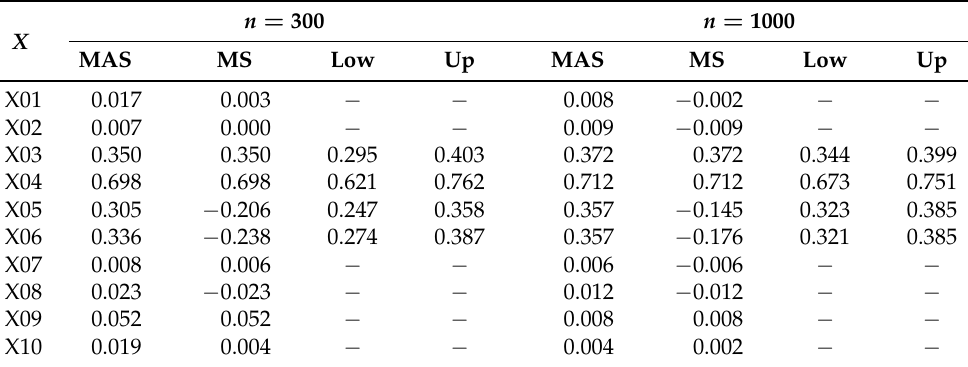
Table 2. Model M1 (Tibishirani), mean absolute sensitivity (MAS), mean sensitivity (MS), lower (Low) and upper (Up) bootstrap confidence interval limits with B = 1999 replicates and nominal level 1 − α = 0.90, for n = 300, and n = 1000 observations. For those variables that were not relevant, no confidence limits are reported.